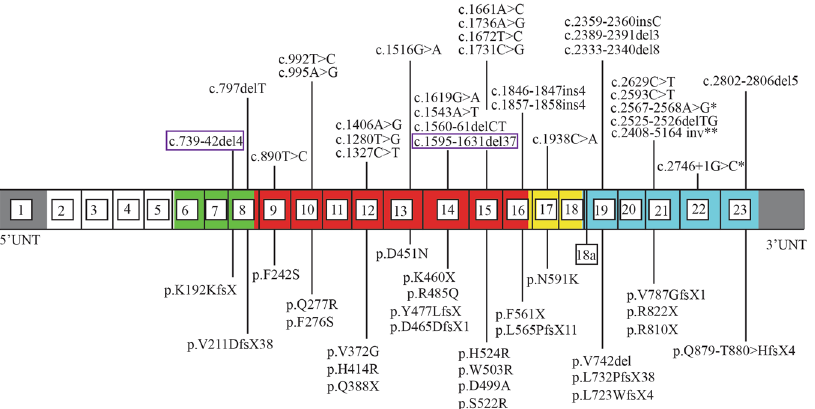
Figure 5. Mapping of known mutations associated with congenital glaucoma in OCRL1 gene and OCRL protein domains. Thirty OCRL1 mutations, including the two we identified in this paper, have been identified so far in Lowe Syndrome patients with congenital glaucoma. These mutations are the result of a variety of mutations including insertion, deletion, and inversion mutations which have caused a spectrum of reading frame shifts, truncated proteins, and disease phenotypes. The two novel mutations discussed in this paper are highlighted by the purple rectangles. * Refers to intronic mutations that caused splicing defects. ** Refers to a mutation that caused gross inversion. Exons including the alternatively spliced exon 18a are numbered 1 to 23. The PH domain is shown in white, 5-phophatase domain is indicated in red, the ASPM-SPD-2Hydin (ASH) domain in yellow, the RhoGAP-like domain in blue, the linkage domain between the PH and 5-phophatase domain in green, and the untranslated regions in yellow.